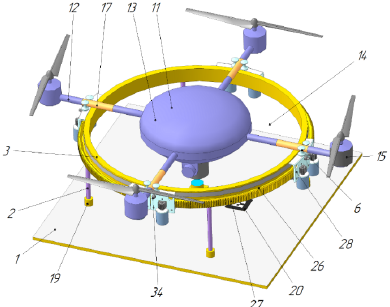
Figure 39. Landing platform for a vertical take-off and landing UAV with an active ring for positioning [95] by Innopolis University. 3, landing site ring; 6, pushers; 11, UAV; 12, UAV beams; 28, pusher